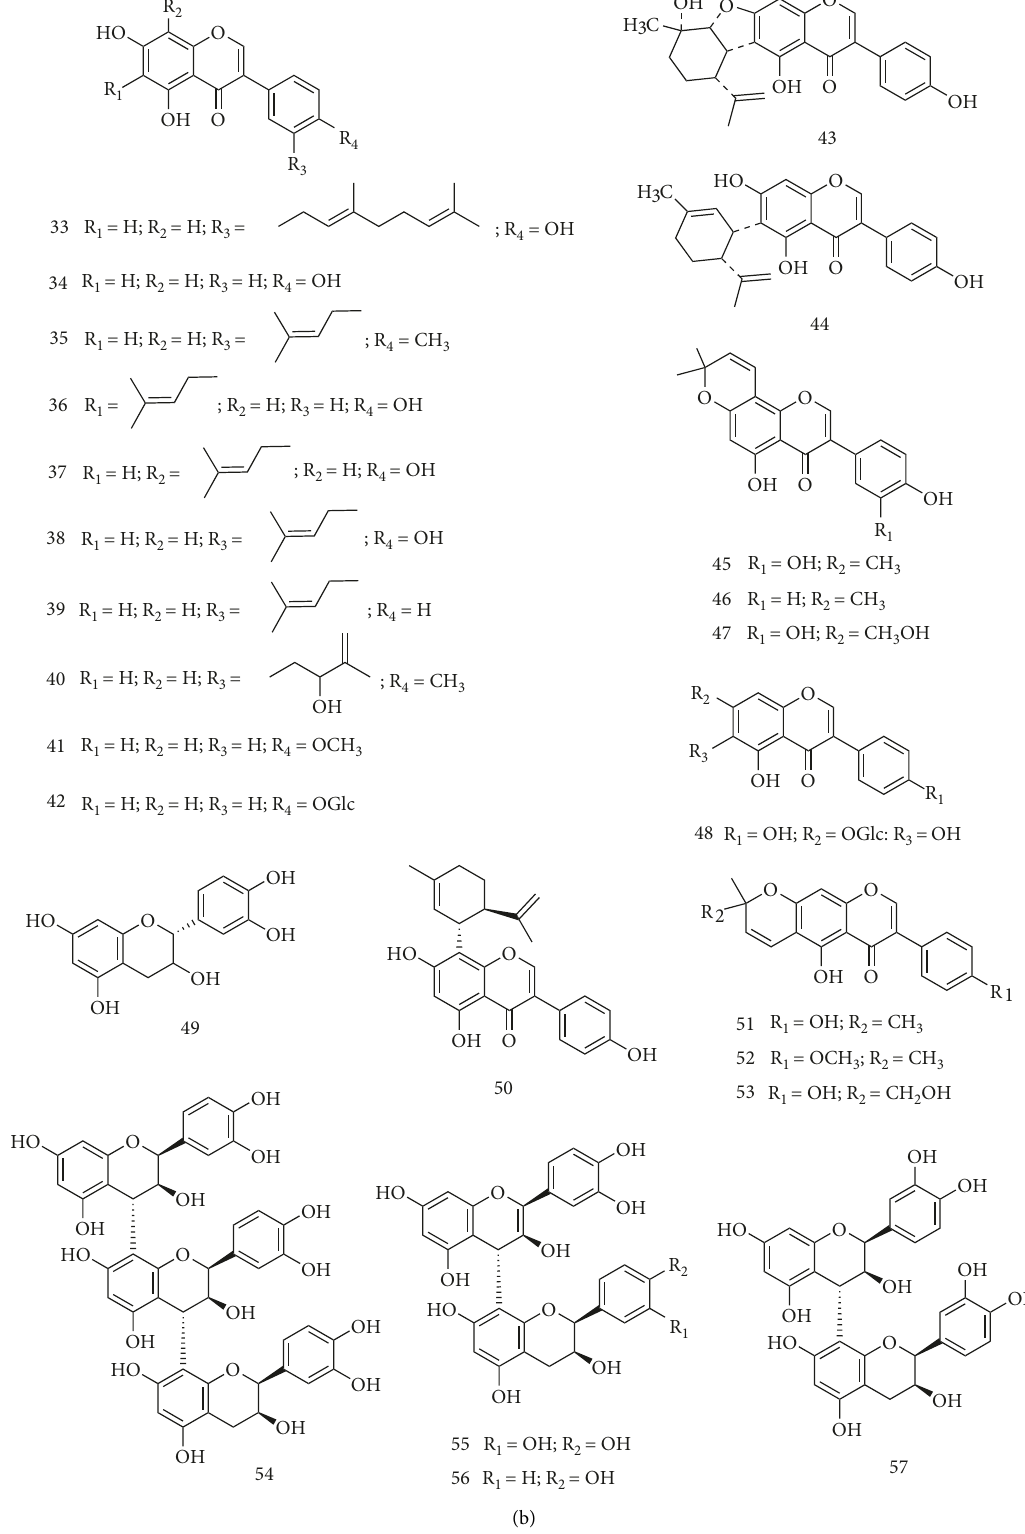
Figure 1: Structures of the flavonoids and lignans found in F. tikoua